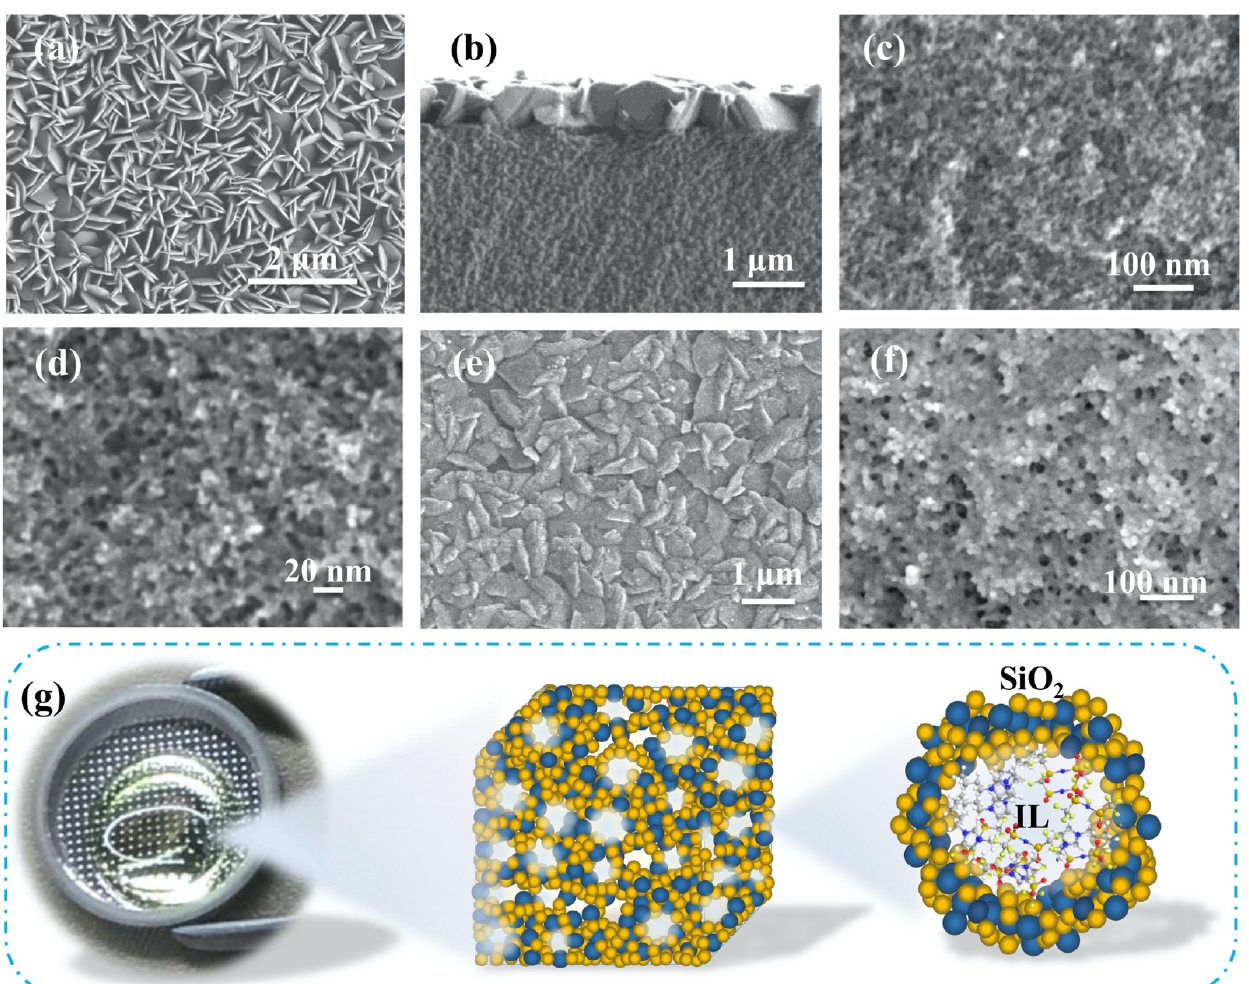
Figure 1. ( a ) FESEM image of the surface of IE-T electrolyte; ( b ) FESEM image of the cross-section of IE-T electrolyte; ( c and d ) FESEM images of the IE-T electrolyte sample after ionic liquid has been extracted; ( e ) FESEM image of the surface of IE-B electrolyte; ( f ) FESEM image of the IE-B sample after ionic liquid has been extracted; ( g ) photograph of IE-T electrolyte and schematic of internal microscopic three-dimensional structure of ionogel. Reprinted with permission from ref. [30].